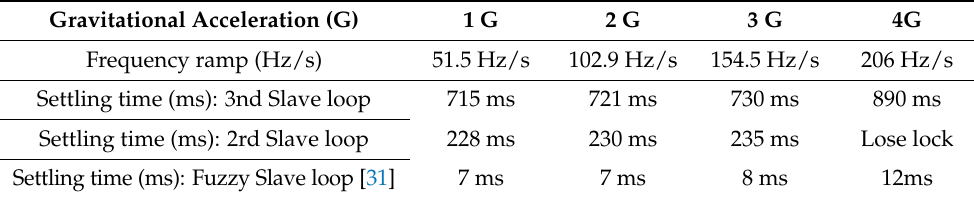
Table 3. Settling time of the primary loop ( T S , pri ) analysis.